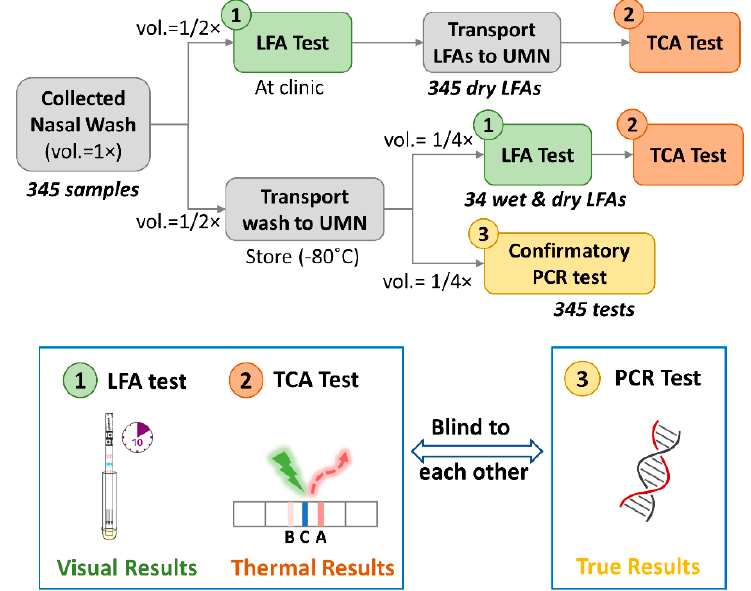
Figure 1. Schematic flowchart of the prospective cohort study. The nasopharyngeal samples were collected (sample volume as 1 unit, i.e., vol. = 1×) and tested by lateral flow assays (LFAs) (available sample vol. = 1/2×) at a local primary care clinic. The remaining wash (further aliquoted into 2 halves, i.e., vol. = 1/2×2) and LFAs were transported to the UMN for confirmative polymerase chain reaction (PCR) tests (available sample vol. = 1/4×) and thermal contrast amplification (TCA) tests (available sample vol. = 1/4×). A comparison of the TCA tests on wet and dry LFAs was conducted on 34 of those wash samples. The operators for the LFA and TCA tests and those for the PCR tests were blind to each other’s results during the experiments. Visual results were recorded after LFA tests while thermal results were obtained from TCA tests. The results from PCR tests were viewed as true results. UMN: University of Minnesota ; vol.: volume.